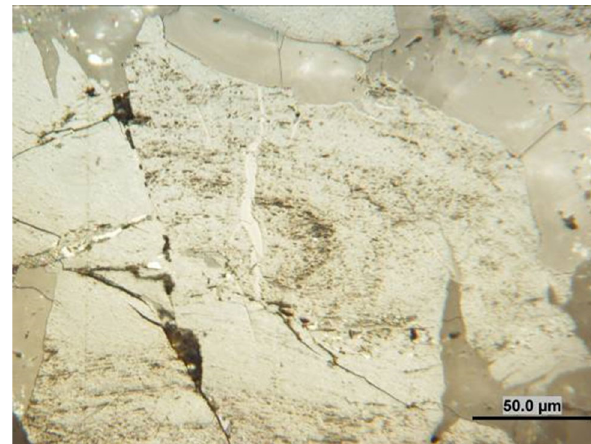
Fig. 10 Vitrinite with finely dispersed sporinite, resinite, liptode- trinite and bituminite, faulted by cracks